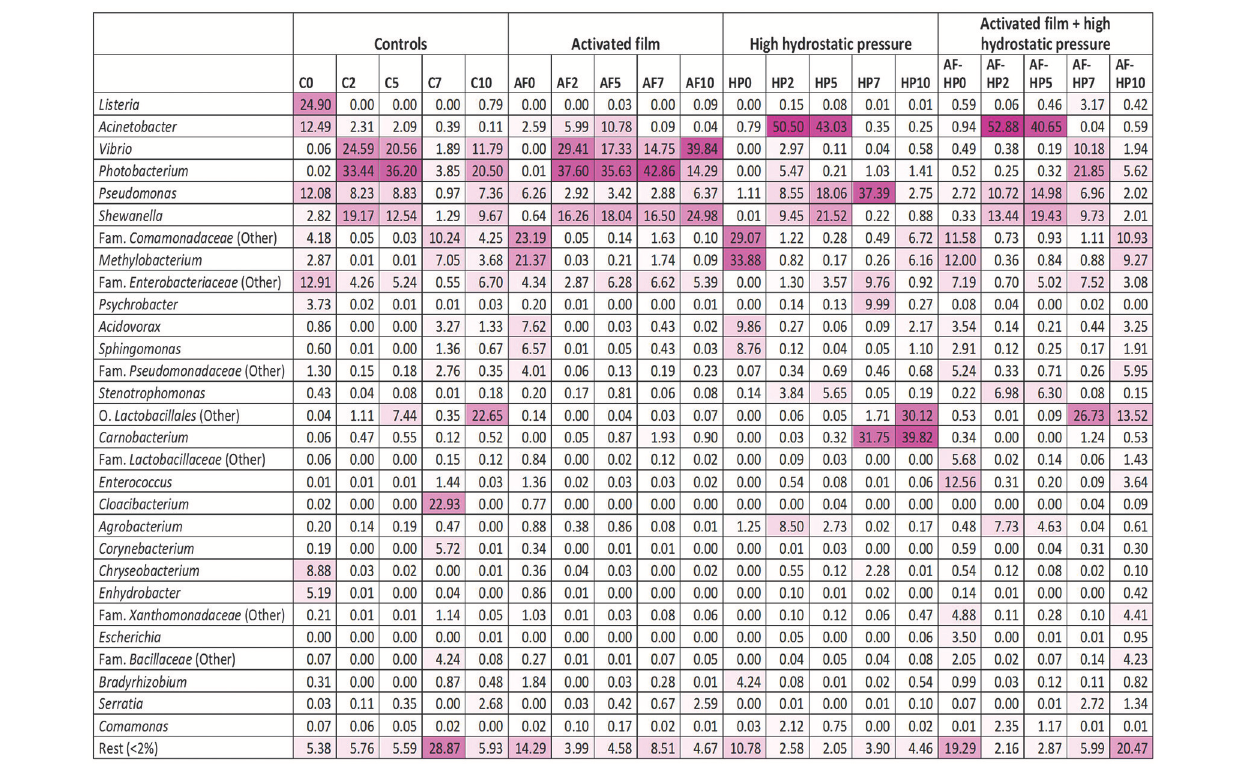
FIGURE 2 | Heatmap of bacterial diversity in sea bream samples based on the relative abundance at genus level. The values represent the relative abundance of OTUs clustered at the Genus level. OTUs not assigned to genus were computed in the nearest higher taxonomic level. Color scale: 0, white; 100, dark magenta. Controls packed in films without activation with antimicrobials (C); samples packed in films activated with thymol plus enterocin AS-48 (AF); samples packed in films without activation and treated by high-hydrostatic pressure (HP); samples packed in activated films and treated by high-hydrostatic pressure (AF-HP). Sampling was performed at days 0, 2, 5, 7, and